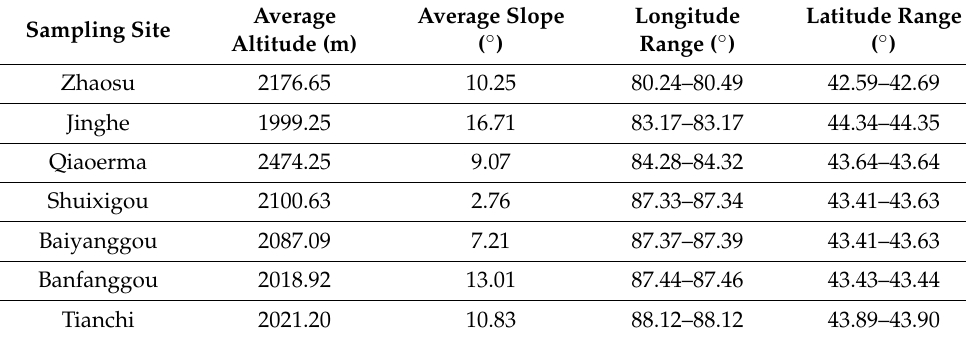
Table 1. The topography of sampling